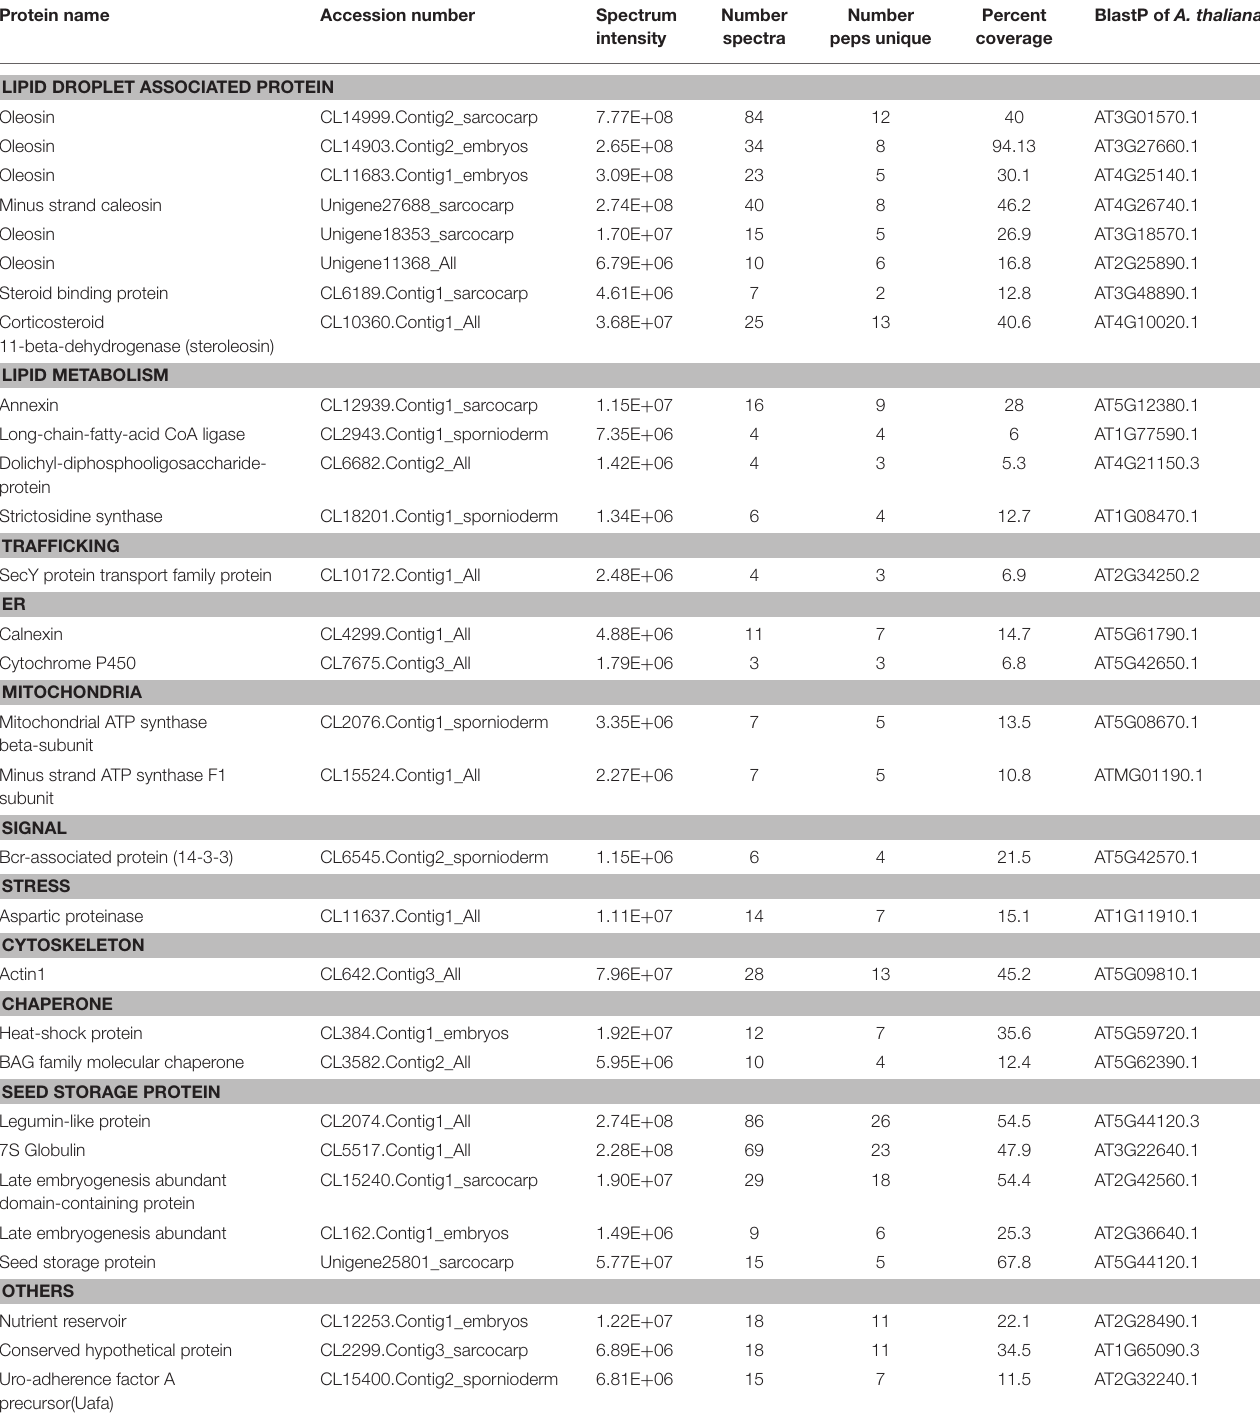
TABLE 1 | Proteins identified (with intensity over E + 06) from LDs purified from seed kernel of Triadica